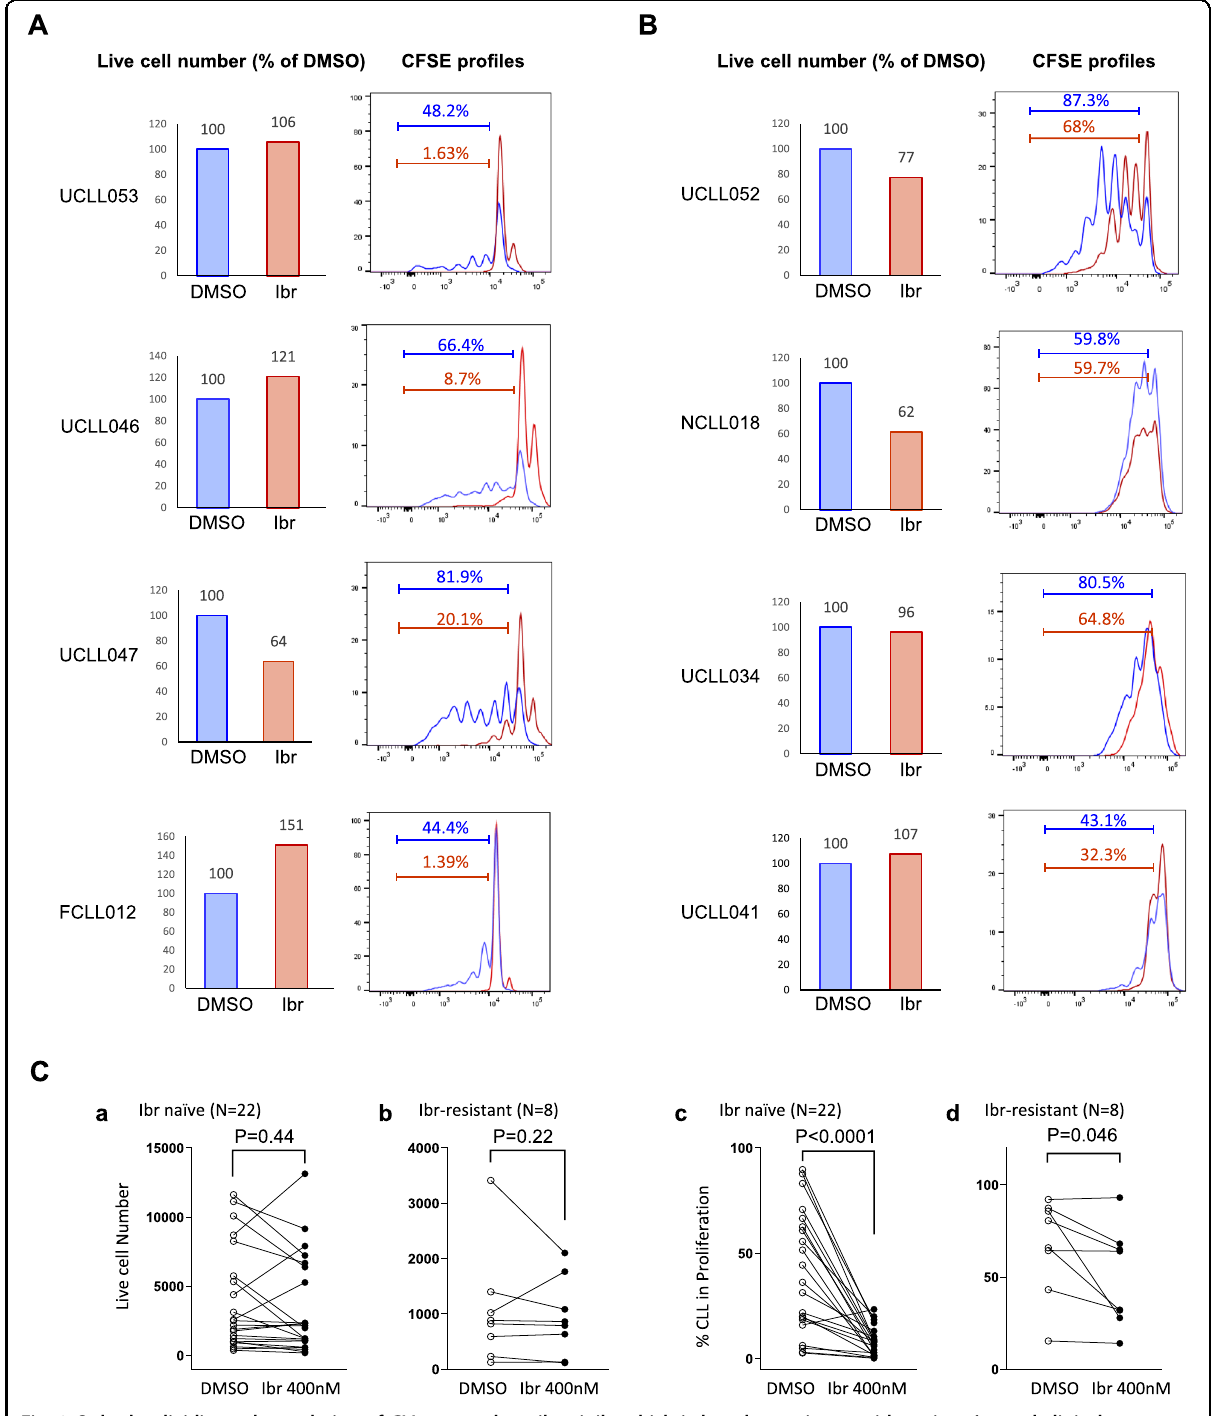
Fig. 2 Only the dividing subpopulation of CLL responds to ibrutinib, which is largely consistent with patients ’ actual clinical response. CFSE-labeled CLL cells were cultured with BMF + CpG/IL-15 in the presence of DMSO or 400 nM of ibrutinib (Ibr). All analyses shown were conducted at day 7 of the co-culture by fl ow cytometry. A Live cell numbers (bar graphs) and CFSE pro fi les of 4 ibrutinib naïve/sensitive cases. Live cell numbers were normalize to the DMSO control (100%). Percentage of cells distributed in the dividing phases of the CFSE pro fi les is automatically calculated by the FlowJo software. B Live cell numbers and CFSE pro fi les of 4 ibrutinib resistant cases. C Aggregate results of cell viability and % of dividing CLL cells are shown for ibr naïve patients (a and c) as well as ibr resistant patients (b and